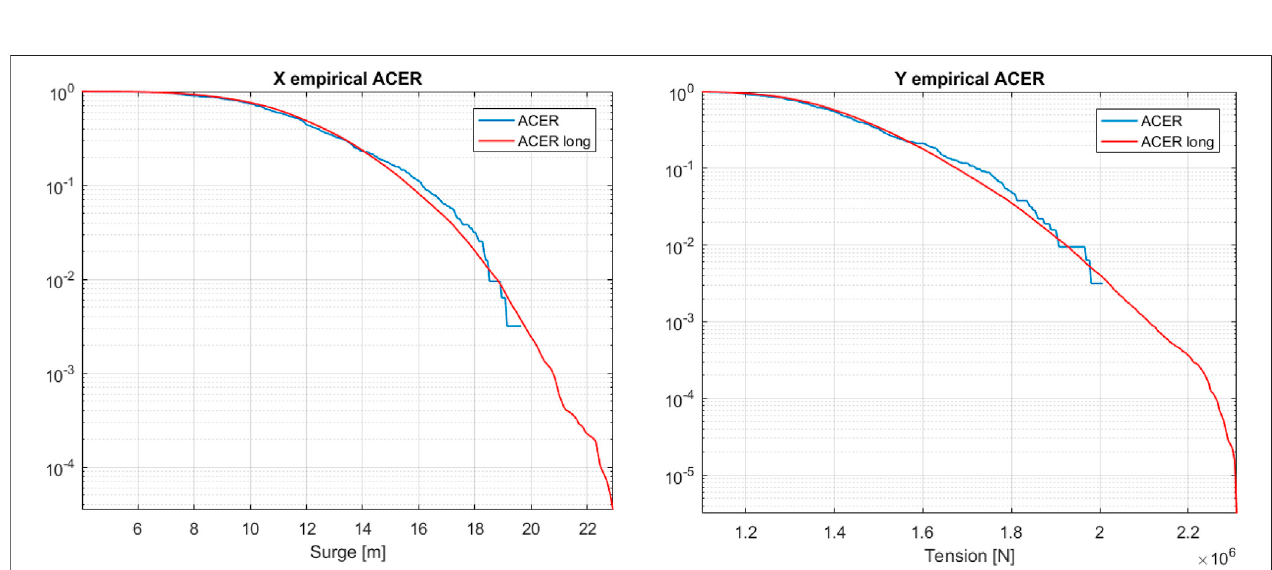
FIGURE 5 | ACER functions for shorter and longer FWT response records: Surge and Tension FWT responses, upper and lower fi gures, respectively. The ACER function decimal logarithm values are on the vertical axes. Mean current velocity 8 m/s.